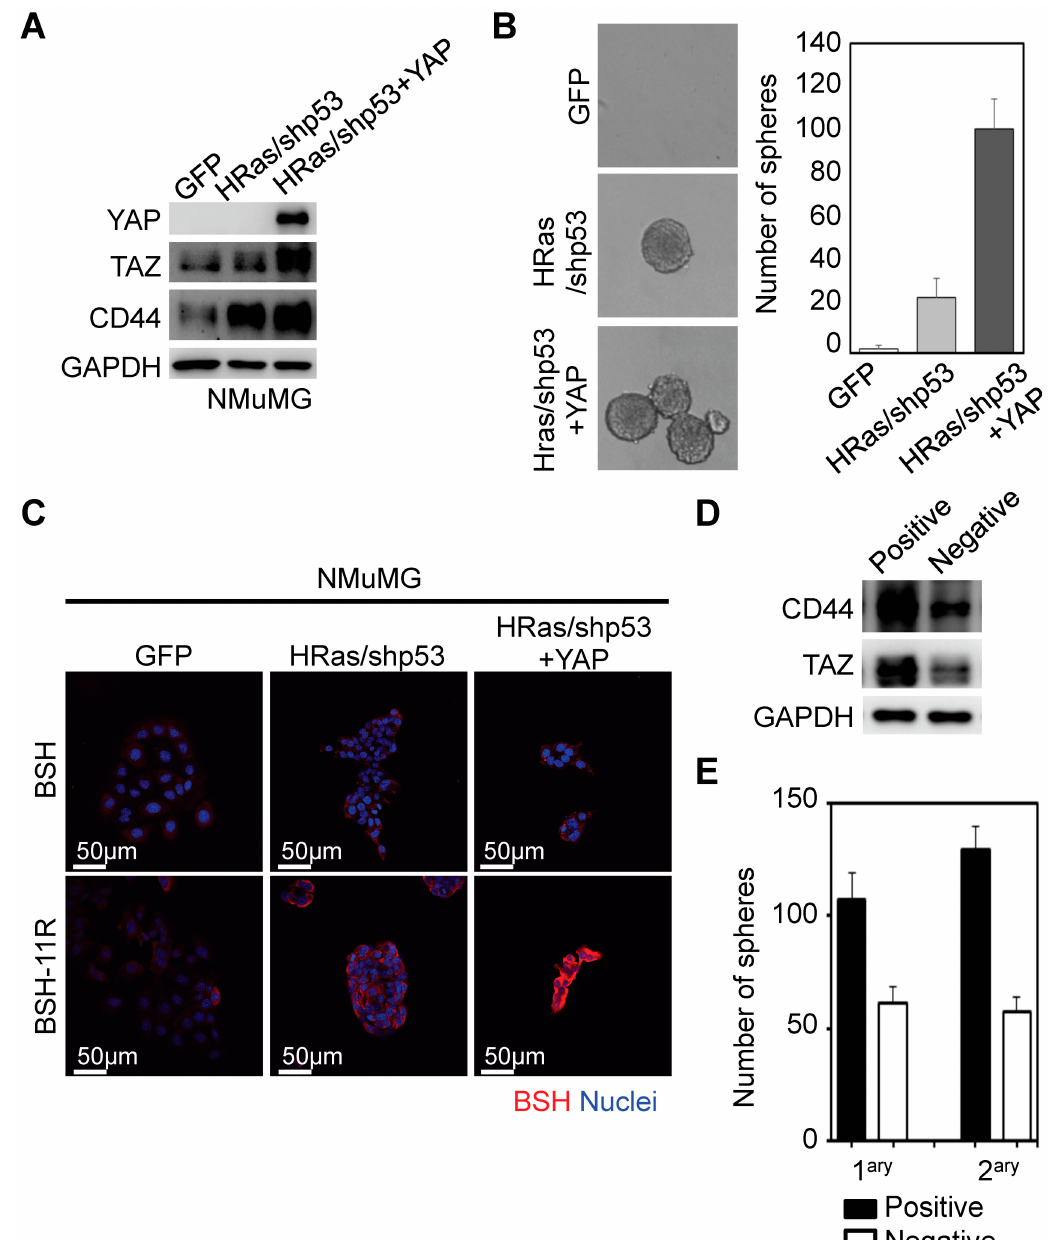
Figure 4. BSH-11R was efficiently delivered to cancer stem-like-cells. ( A ) Transformation with HRas and shRNA-p53 induced CD44 expression in NMuMG cells (normal murine mammary gland epithelial cells). Exogenous YAP further increased the CD44 expression level. ( B ) The transformed NMuMG cells acquired the capacity for self-renewal and anchorage-independent growth. ( C ) BSH-11R penetrated the transformed cells and efficiently accumulated in cancer stem-like cells (HRas/shp53+YAP). ( D , E ) BSH-11R-bound cells harbored the cancer stem cell-related traits such as abundant expression of CD44 and TAZ and the capacity for self-renewal.